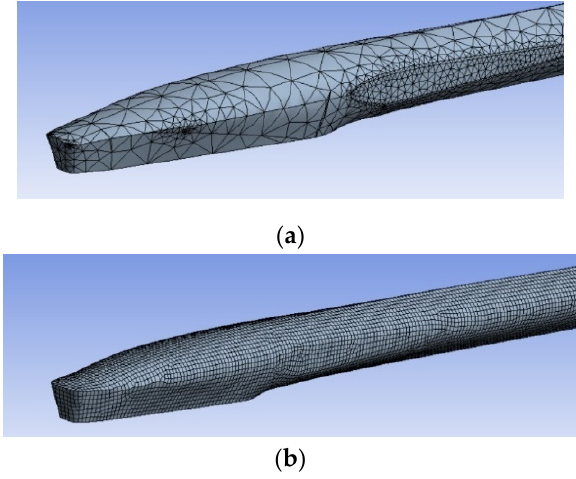
Figure 9. Flexural test set for the fuselage ( a ) CFRP fuselage, ( b ) QQF Fuselage .